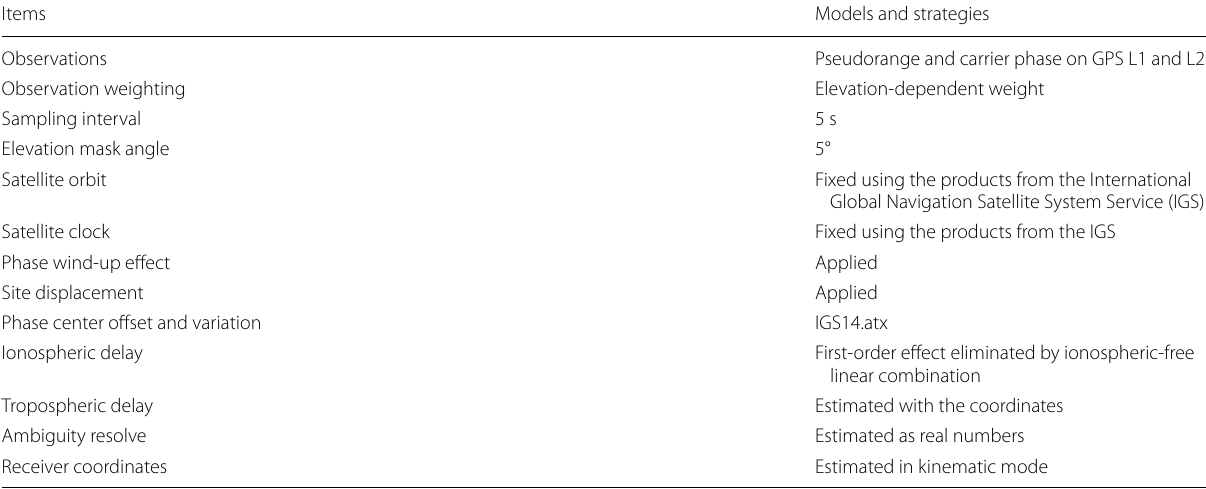
Table 1 Summary of PPP processing models and strategies